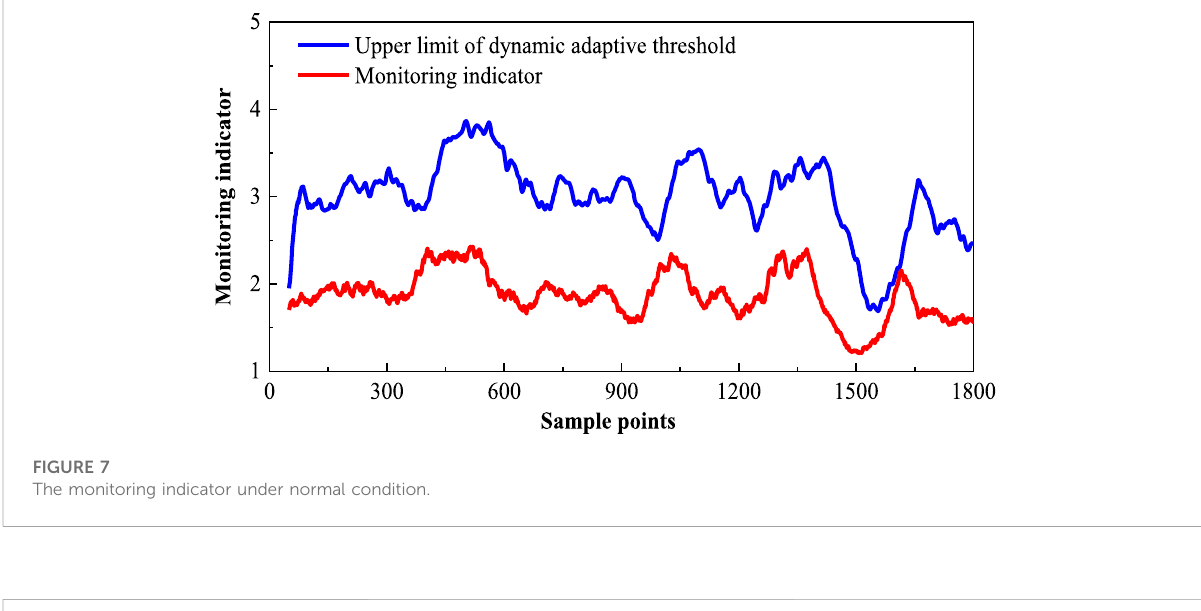
FIGURE 7 The monitoring indicator under normal condition.